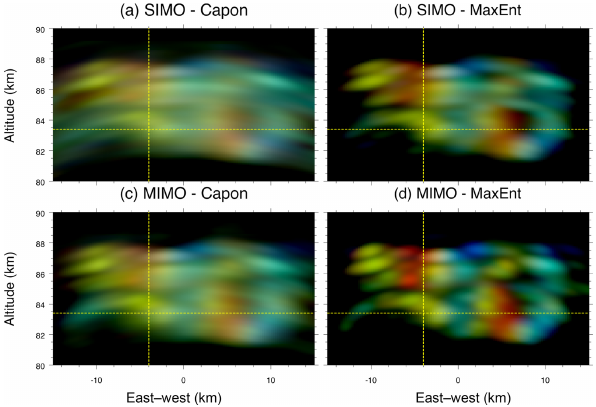
Figure 6. Same as Fig. 5 but for an EW–altitude cut at y = − 6km. The yellow dashed horizontal lines represent the location of the al- titude cuts shown in previous and later figures for Event